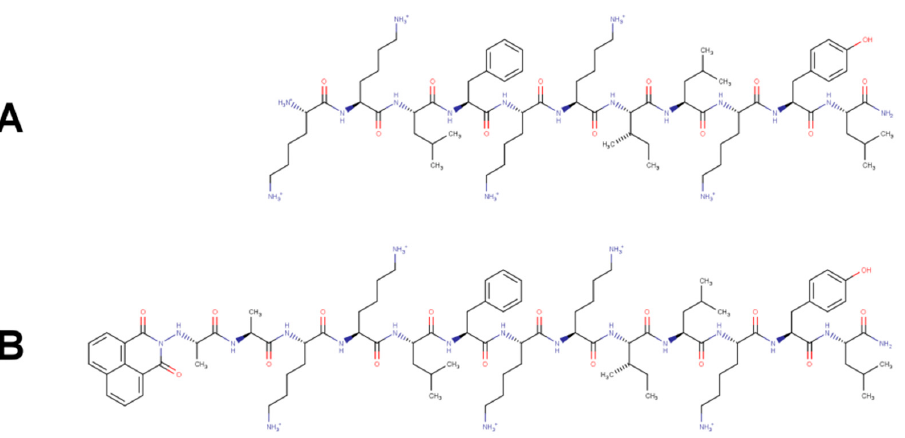
Figure 1. Structures of BP100 (KKLFKKILKYL ‐ NH 2 ) ( A ) and Naphthalimide ‐ AA ‐ BP100 (1,8 ‐ Naphthalimide ‐ AAKKLFKKILKYL ‐ NH 2 )(NAPHT ‐ BP100) ( B ).